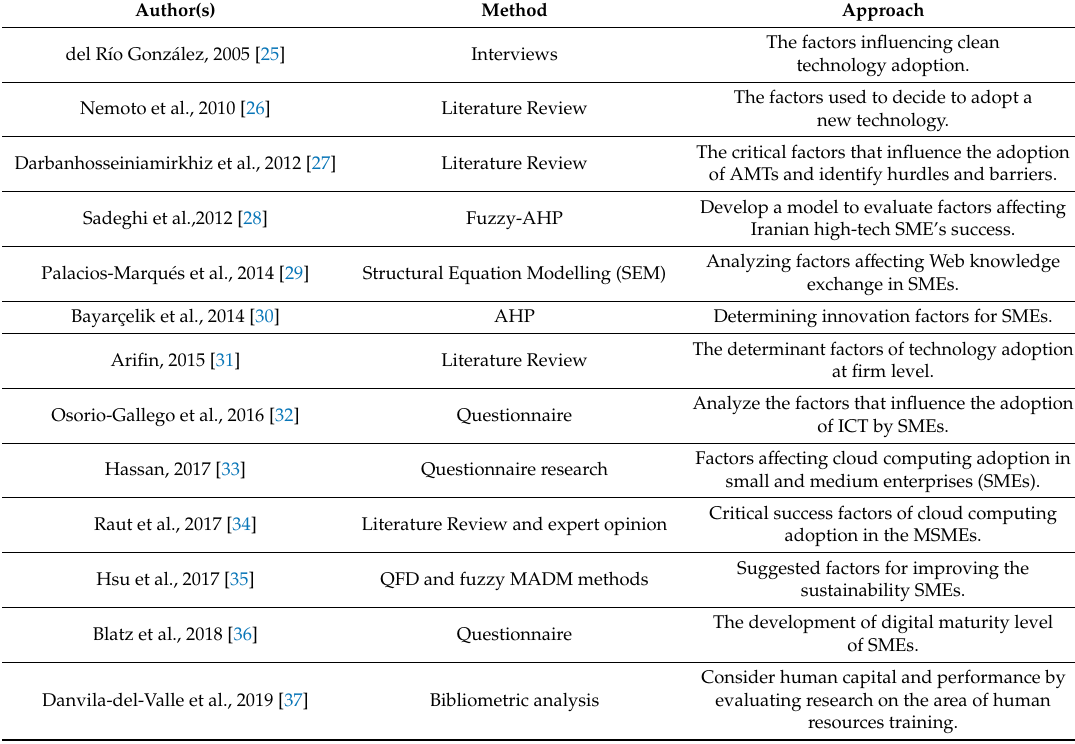
Table 1. Methodology for aspects